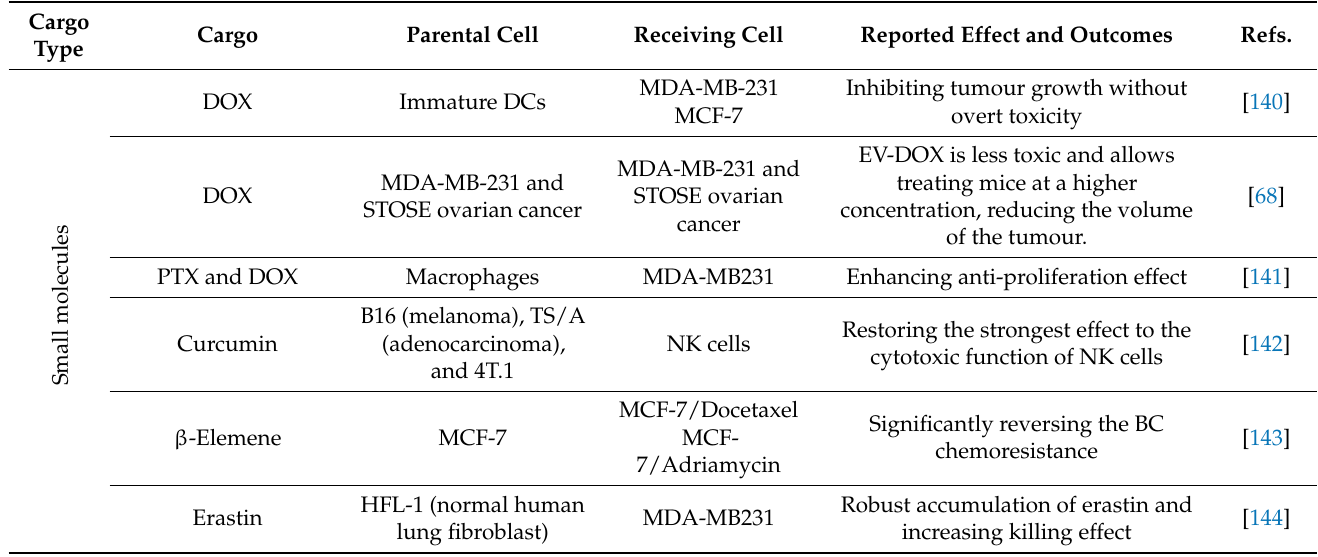
Table 2. Cargo encapsulated in EV-NDDS for TNBC and BC